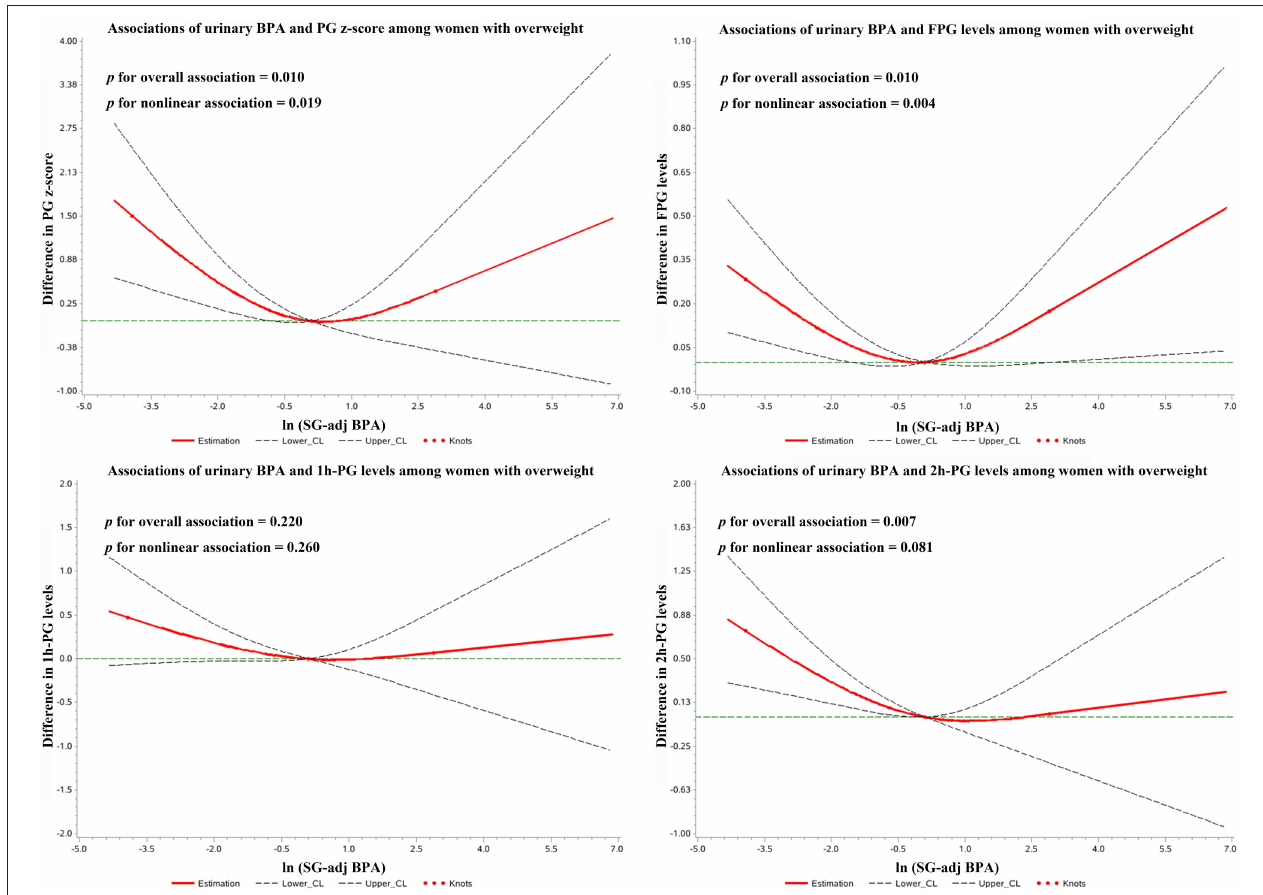
FIGURE 1 | Restricted cubic spline for the associations between urinary BPA and plasma glucose levels among women with overweight. The red lines represent differences in glucose levels for natural log transformed specific gravity adjusted urinary BPA concentration with adjustment for maternal age, educational levels, parity, passive smoking, and fetal sex. Knots were set at the 5th, 50th, 95th percentiles and the reference value was set to median of urinary BPA distribution among women with overweight. Dashed lines represent 95%